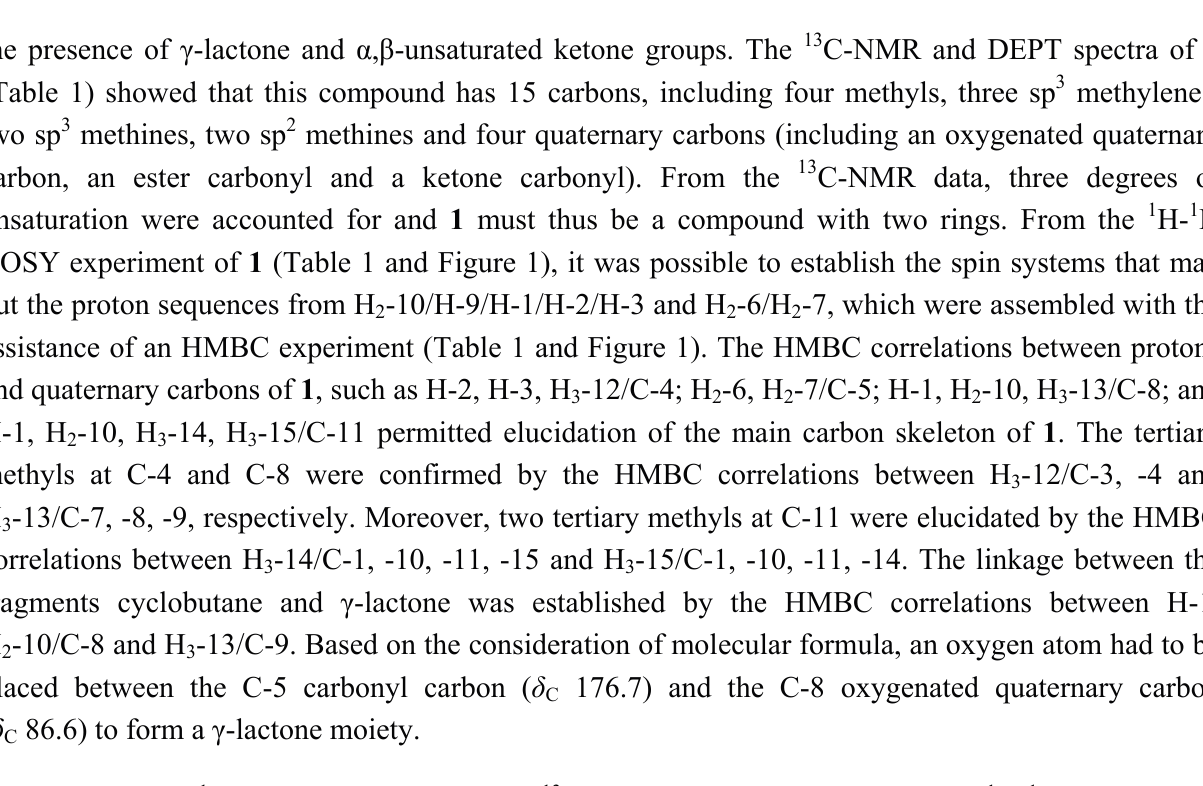
) and 13 C (100 MHz, CDCl 3